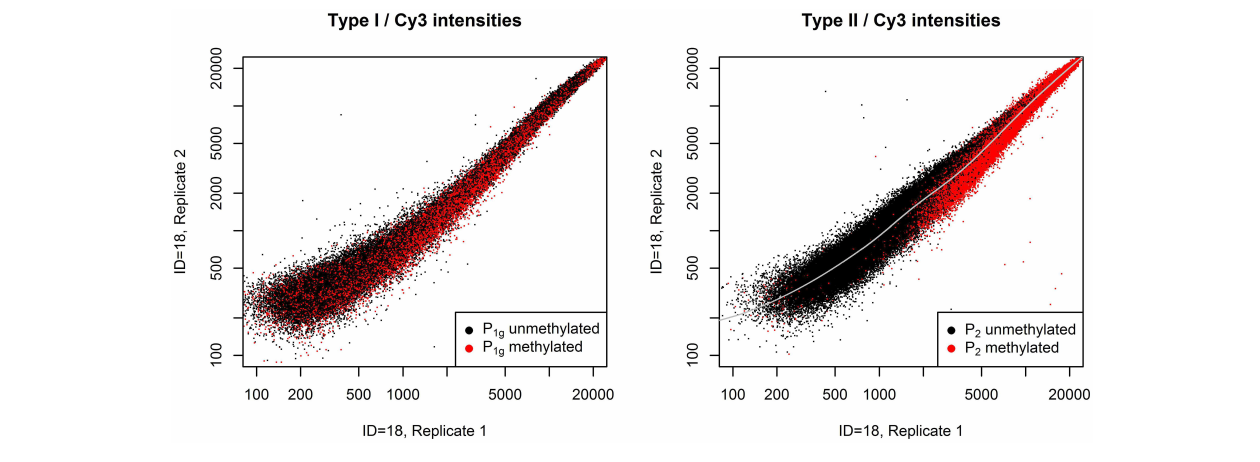
FIGURE 1 | Systematic bias between a pair of technical replicates. Raw Cy3 intensities from a pair of technical replicates from dataset A (see section Benchmarks) for all probes in P 1 g (left panel) or P 2 (right panel). Probes with a m -value less than zero in the first replicate are plotted in black,